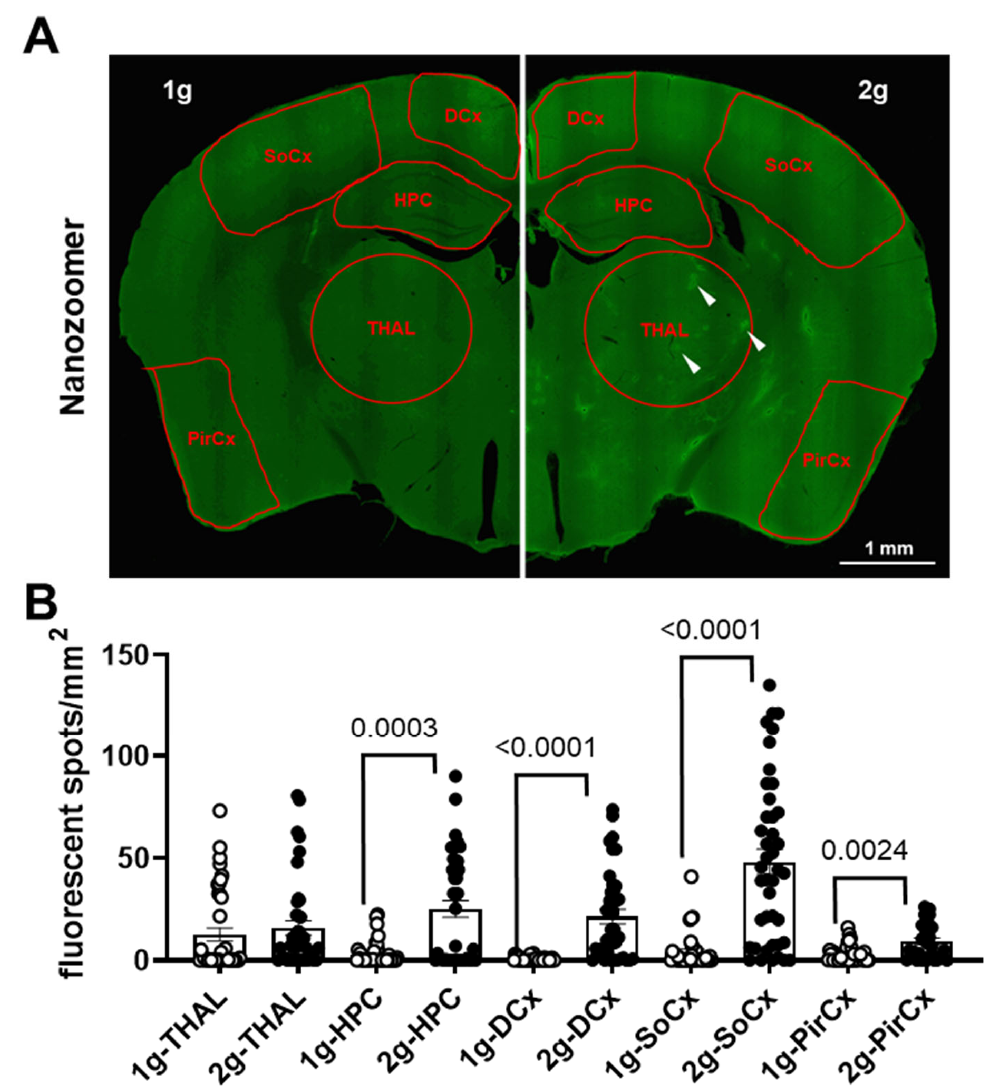
Figure 6. Density of fluorescent spots in brain. ( A ) The brain regions used for the analysis were delimited by red shapes on Nanozoomer image (1 g on the left and 2 g on the right). These red ROI were placed on the thalamus (THAL), hippocampus (HPC), dorsal cortex (DCx), somatosensorial cortex (SoCx) and piriform cortex (PirCx). The white arrows indicate some spots with high levels of fluorescence. ( B ) Density of fluorescent spots (number of spots per mm 2 ) was used as an index of AS diffusion in the brain parenchyma. The 1 g and 2 g conditions are associated with white circles and black points, respectively, and the p values < 0.05 are indicated.